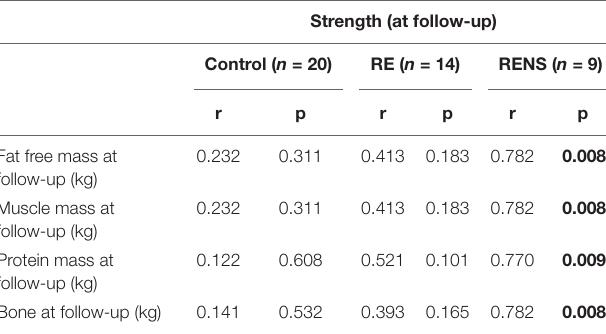
TABLE 3 | Bivariate correlations between strength with anthropometric parameters.